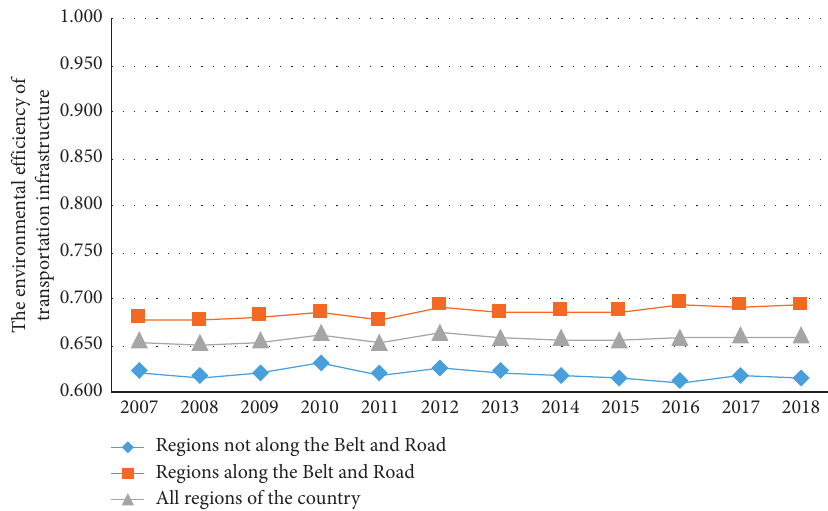
Figure 3: Trending in environmental efficiency of transportation infrastructure.